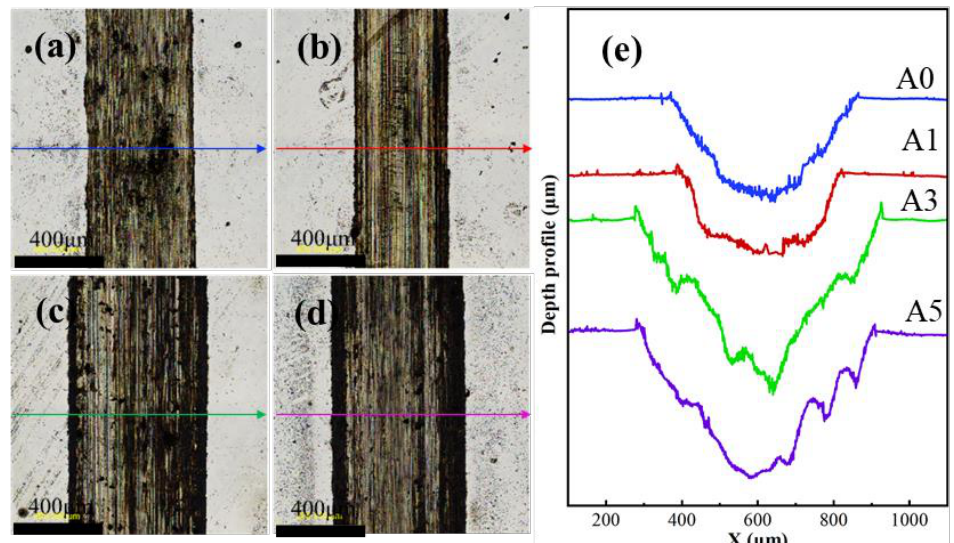
Figure 10. ( a – d ) Two-dimensional diagram of the sample wear marks; ( e ) cross-sections of the samples worn under 70 N for 60 min.